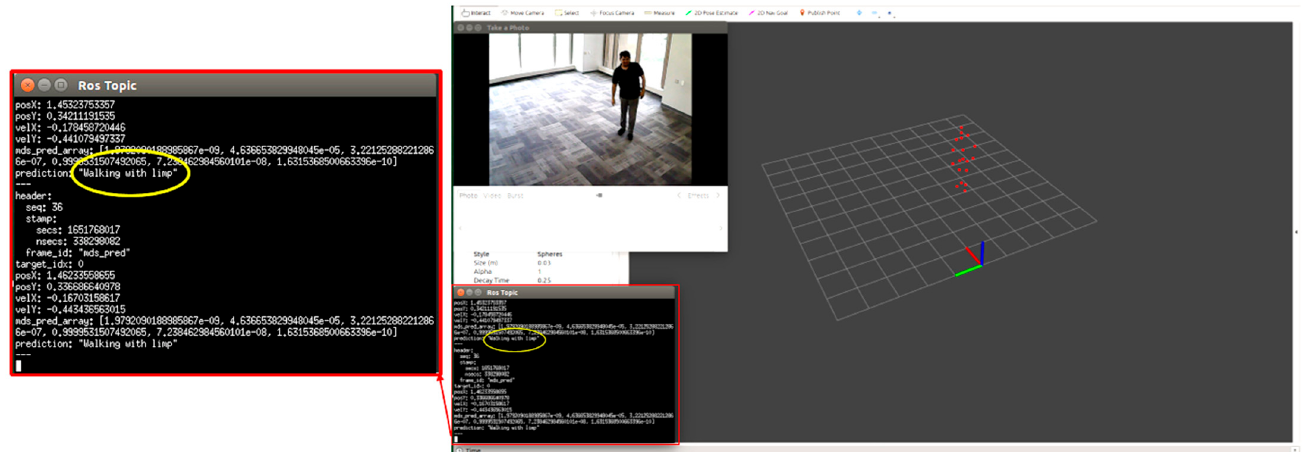
Figure 13. Subject limping. Figure 13. Subject